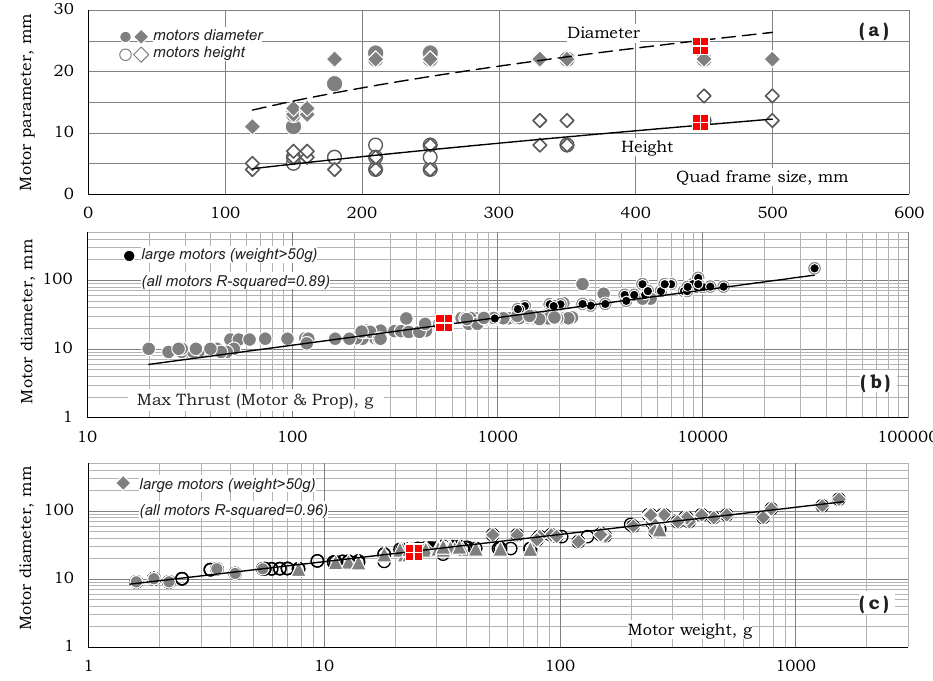
Figure 5. Motor dimensions design trends, [17,18,21,25,26]. In general, a larger motor diameter (wider stator) provides more torque at lower RPM while a higher motor (taller stator) provides more power at higher RPM (see Refs. [21,22]). Nevertheless, both motor diameter and height were found to be well correlated with frame size as shown in Figure 5a: